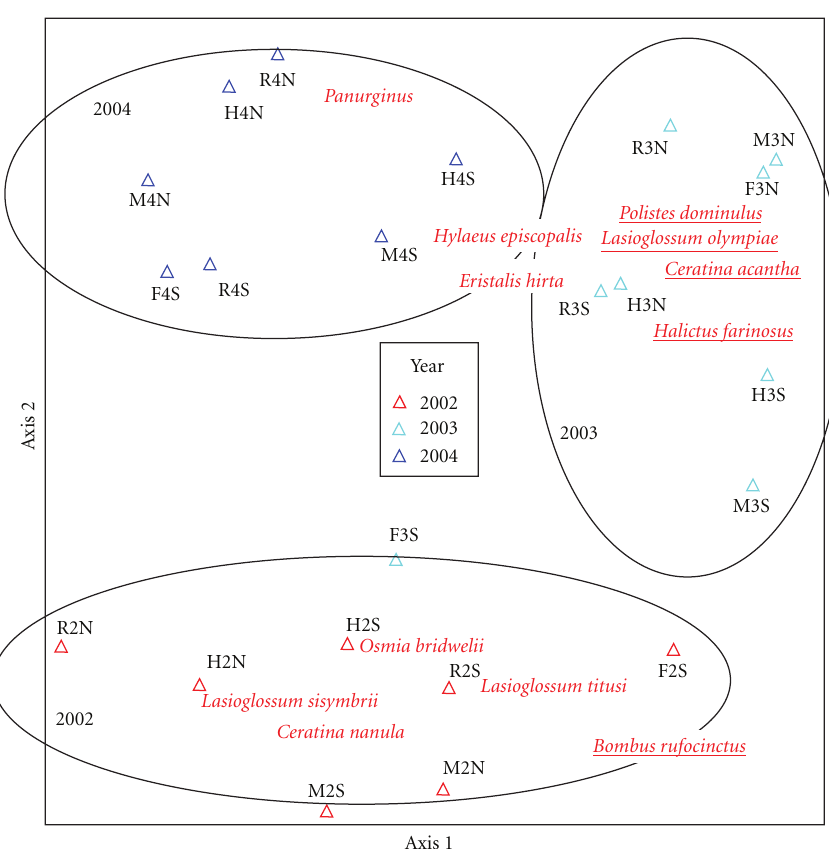
Figure 3: Ordination of sites by species for sulfur and slender cinquefoil pollinator communities at four sites in northeastern Oregon, 2002– 2004. Key to sample acronyms (upright font): M = Morgan; F = Foothill; R = Rice; H = Ham; 2 = 2002; 3 = 2003; 4 = 2004; S = Sulfur; N = Native. Indicator species indicated in italicized font (Axis 2 correlates) and underlined font (Axis 1 correlates).